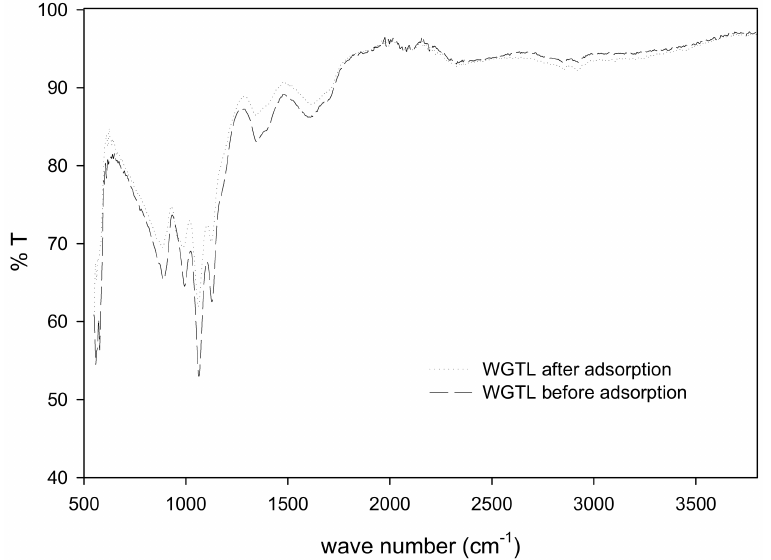
Figure 2. Fourier Transform Infrared Spectroscopy (FTIR) spectra of phenol and WGTLs (before and after